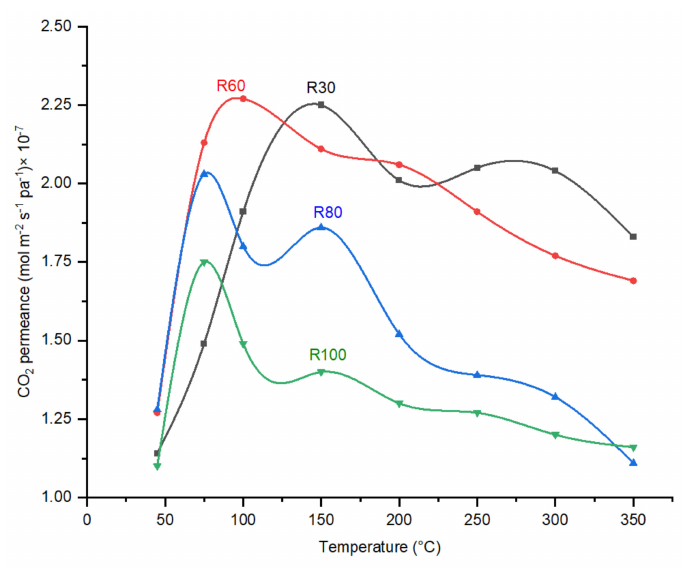
Figure 9. The effect of varying DP (Degree of Polymerization) on the CO 2 permeances of CMSMs (Carbon Molecular Sieve Membranes) as a function of temperature at 6